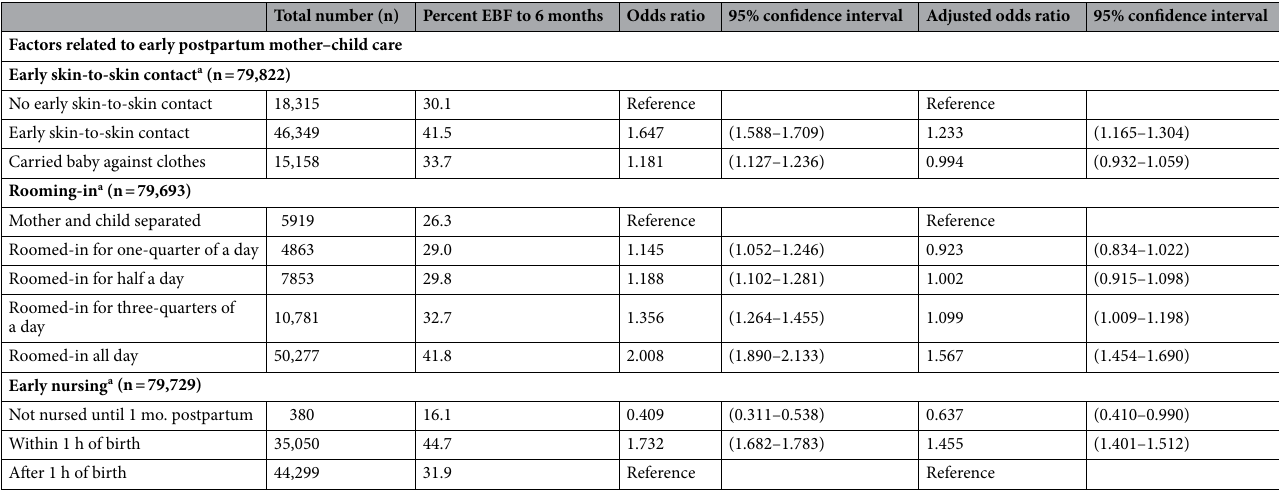
Table 1. Factors related to early postpartum mother–child care influencing EBF rates until 6 months postpartum in Japan. Data acquisition. a 1 month